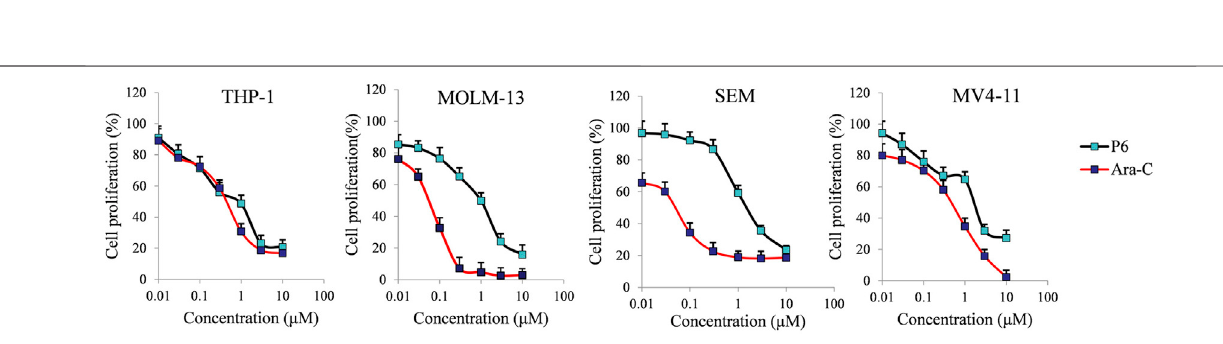
Frontiers in Chemistry |